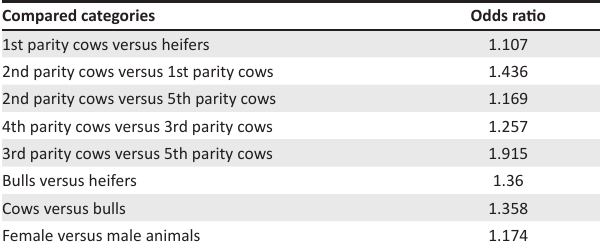
TABLE 5: Odds ratios of categories with statistically insignificant differences since p > 0.05. Compared categories